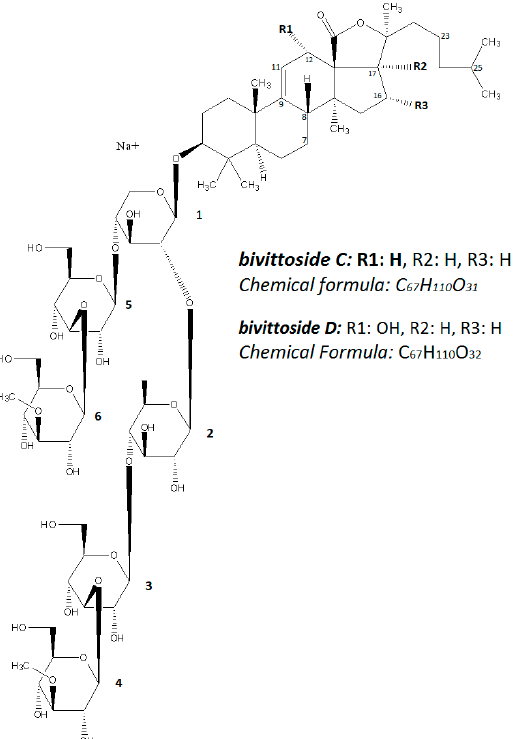
Figure 9. Structure of the two saponin molecules isolated from B. argus (Produced with ChemDraw, version 16.0.1.1(77)).